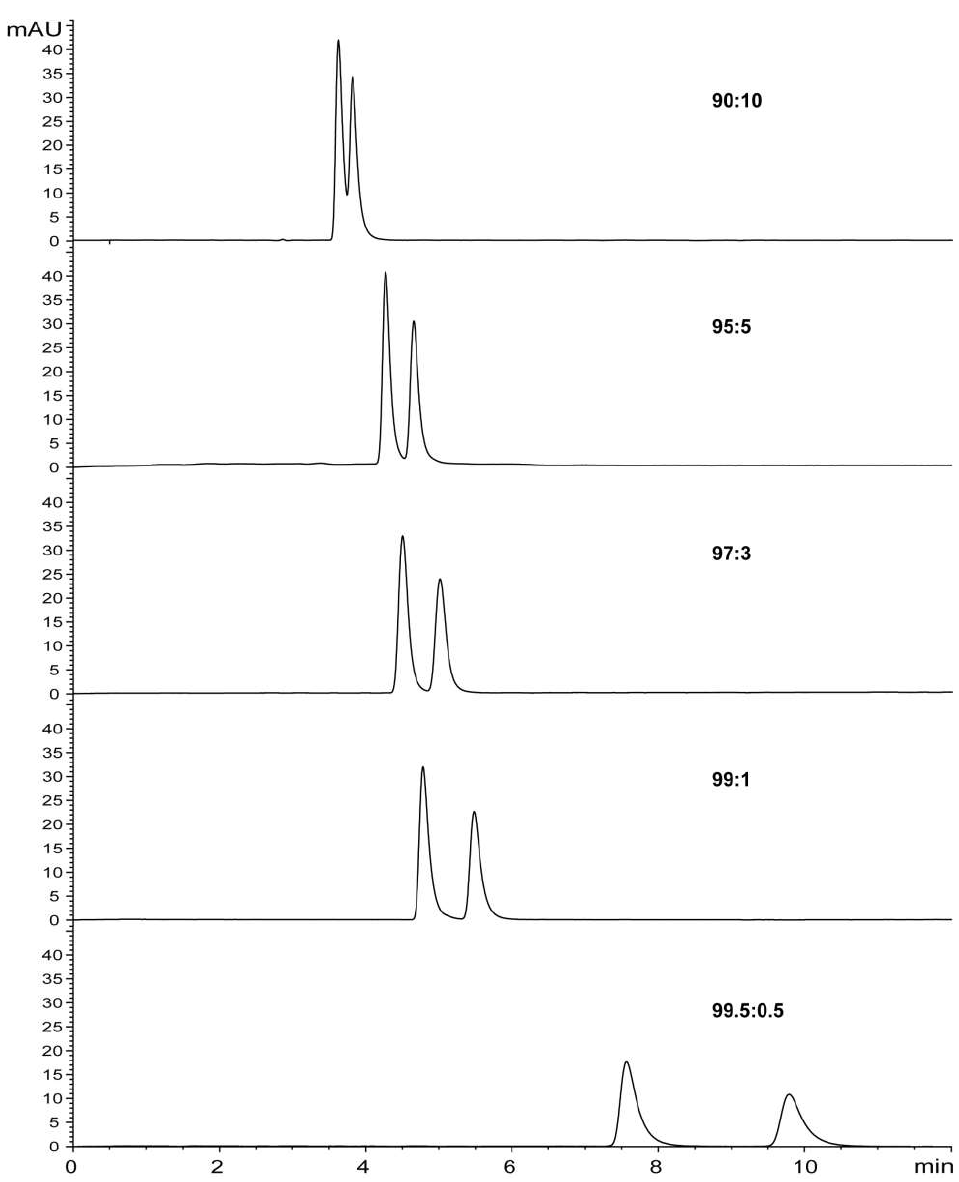
Figure 2. Chromatograms obtained from HPLC analysis of EMP using cyclohexane/isopropanol as eluent.